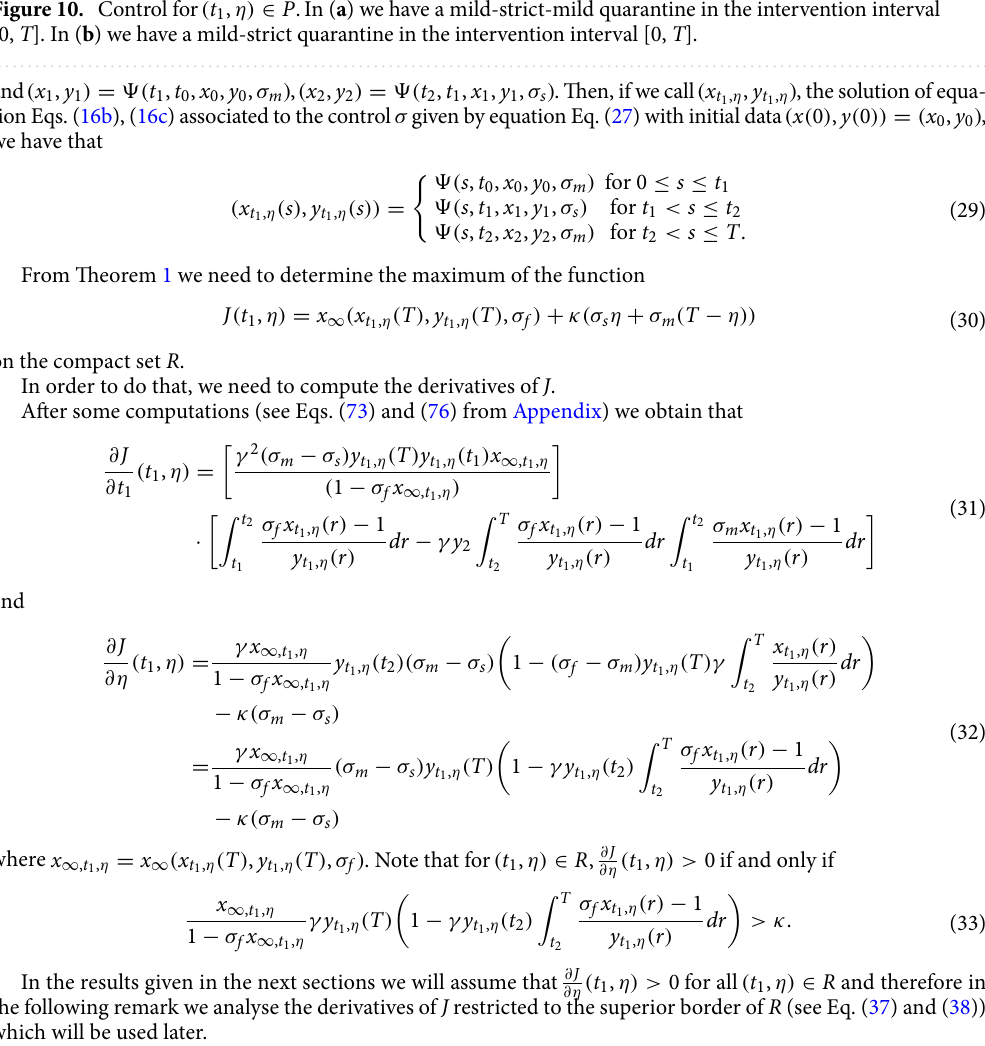
Figure 10. Control for ( t 1 , η) ∈ P . In ( a ) we have a mild-strict-mild quarantine in the intervention